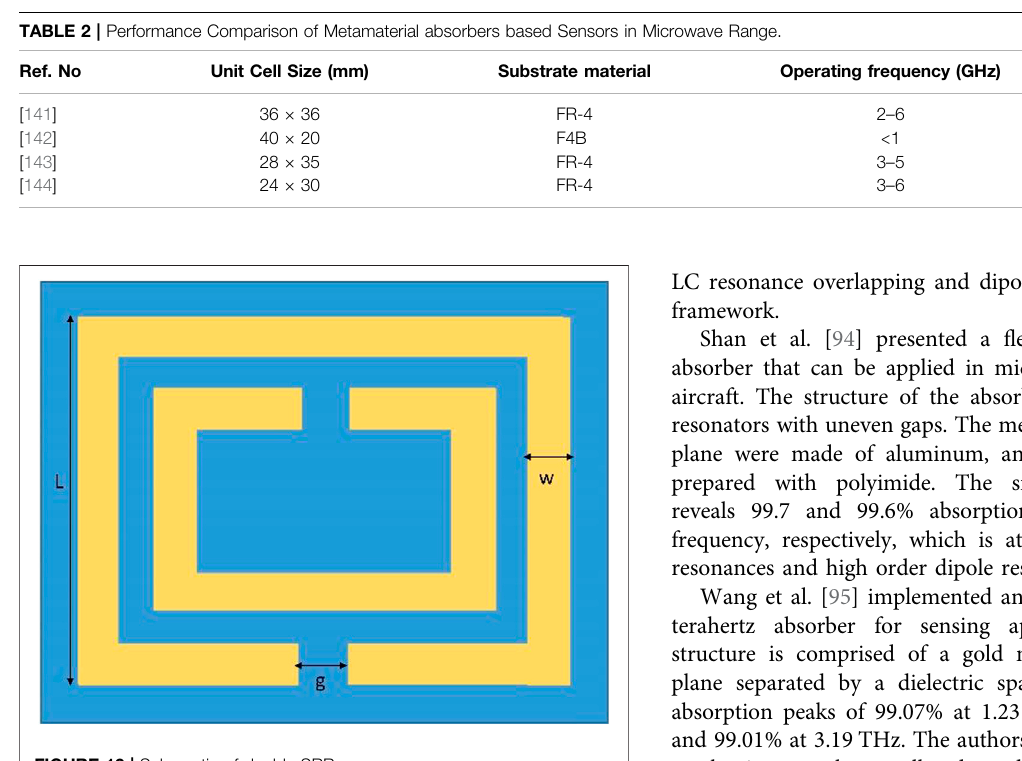
FIGURE 12 | Schematic of double